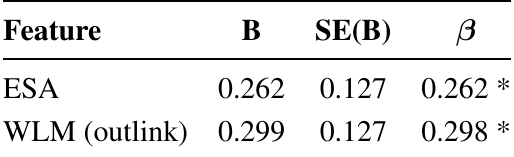
Table 16. Regression of ESA and WLM outlink ranked scores on BAS ranks (N =